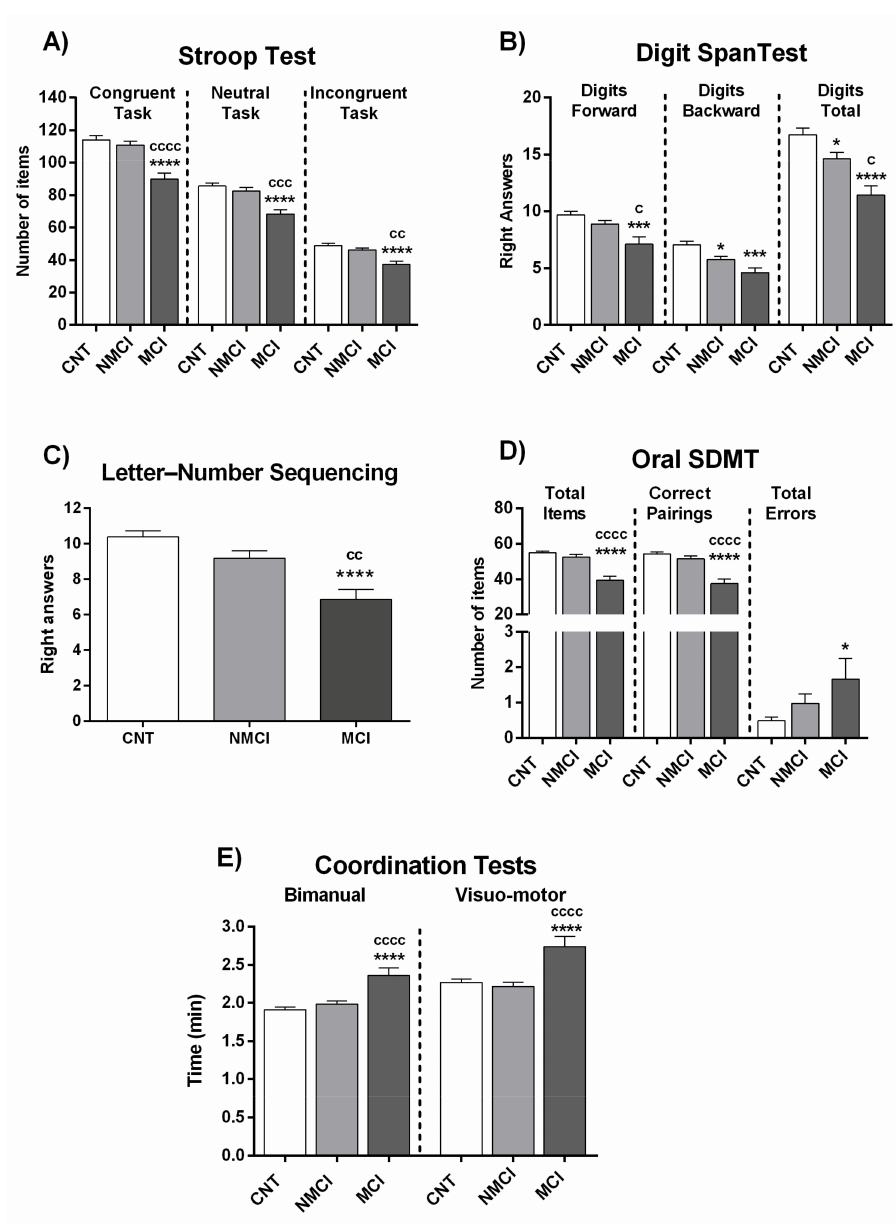
Figure 3. Performance in different psychometric tests of NAFLD patients classified by the new score as with (MCI) or without (NMCI) mild cognitive impairment. ( A ) Results of Congruent (number of words), Neutral (number of colors), and Incongruent (number of items completed) tasks in Stroop test. ( B ) Results of the two tasks of Digit Span test (Digits forward and digits backward), and total Digits score. ( C ) Right answers in Letter-Number Sequencing test. ( D ) Performance in Oral SDMT test. ( E ) Time (min) in Bimanual and Visuo-motor coordination tests. Results are the mean ± SEM. * p < 0.05; *** p < 0.001; **** p < 0.0001 vs. control group (CNT). c p < 0.05; cc p < 0.01; ccc p < 0.001; cccc p < 0.0001, NASH MCI vs. NASH